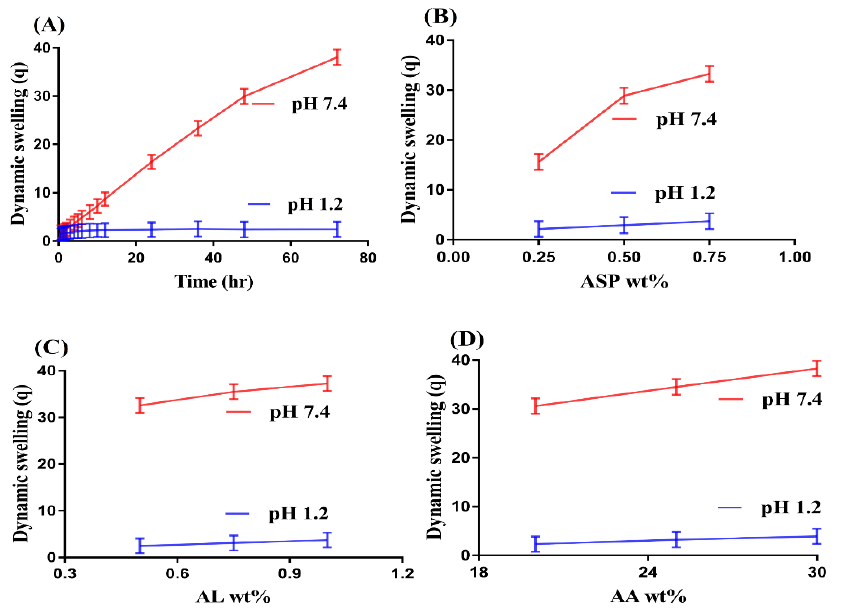
Figure 1. Effect of ( A ) pH, ( B ) Aspartic acid (ASP), ( C ) Alginate (AL), and ( D ) Acrylic acid (AA) on dynamic swelling of ASP/ALPAA hydrogels.